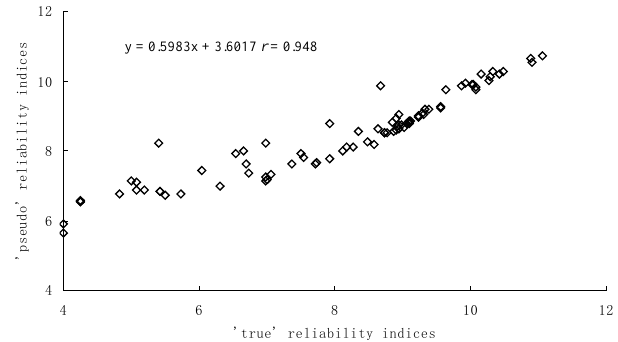
Figure 9. Relationship between pseudo reliability indices and true reliability indices of 86 non-circular trial slip surfaces (normal dis- tribution + load factor method).